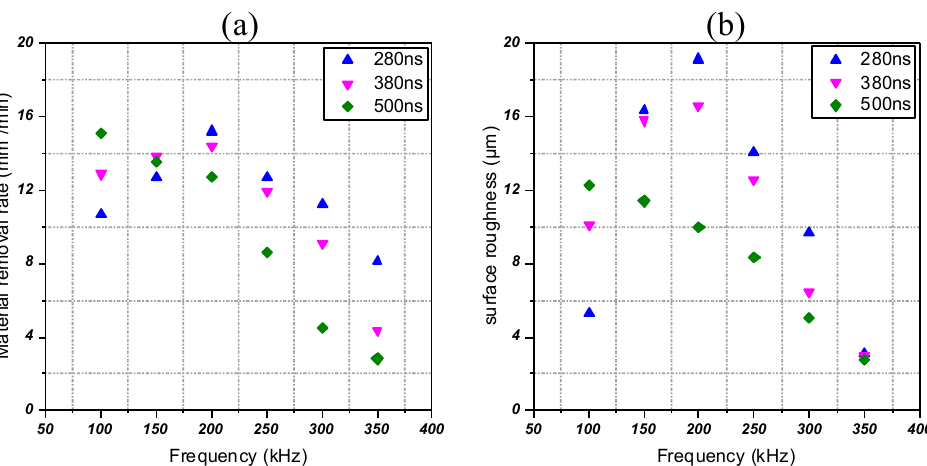
Figure 11. ( a ) MRR and ( b ) S a as a function of PRF and τ at a constant ED A of 4.2 J / mm 2 .